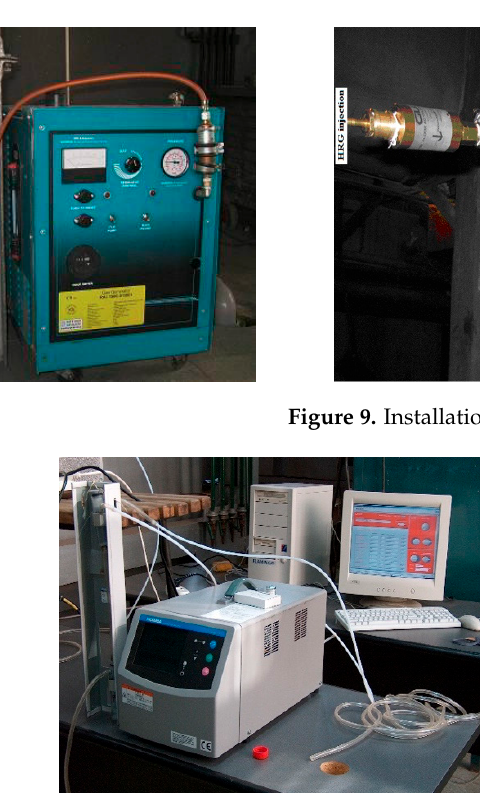
Figure 8. Experimental installation.